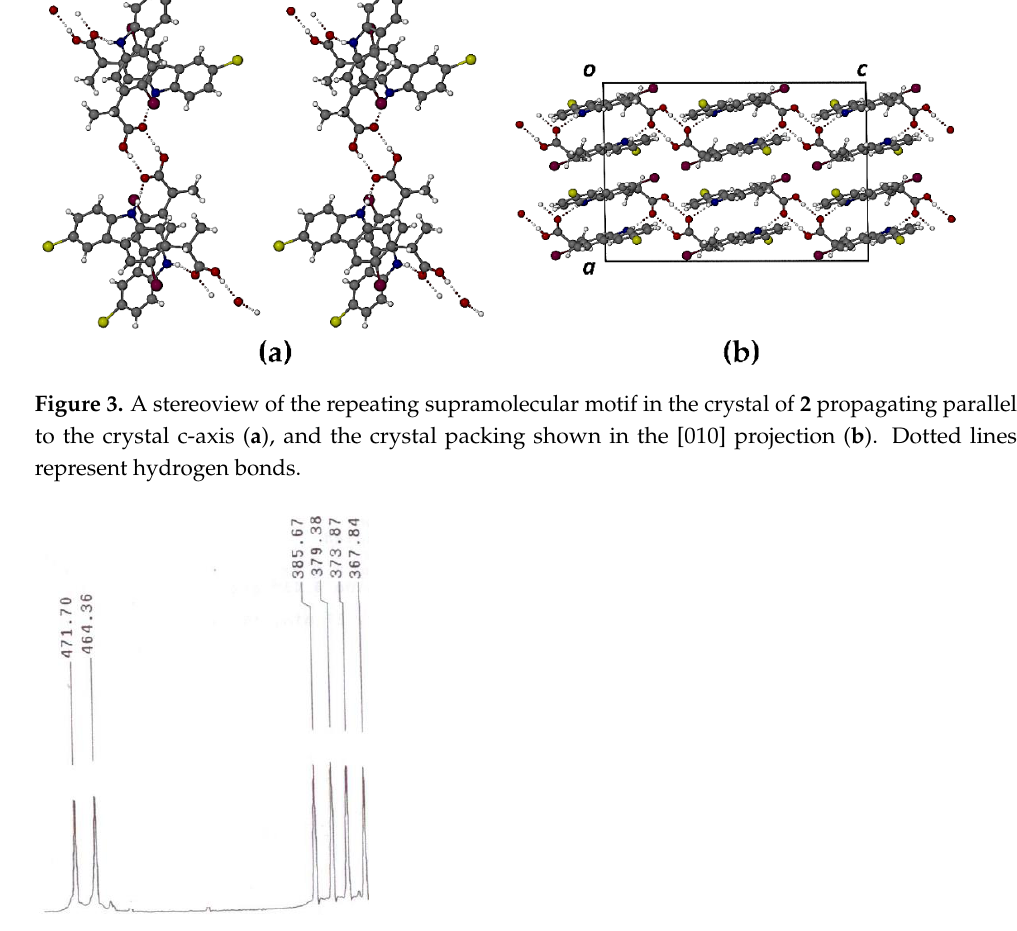
Figure 4. The non-equivalence of methyl protons from the isopropyl radical in the H-NMR spectra of esters 4 and 7 . In the IR-ATR solid spectra of esters 4 – 9 , the functional group absorption frequencies are representative for NH groups (range 3279–3355 cm − 1 ) and those for CO associated with ester groups (range 1701–1716 cm − 1